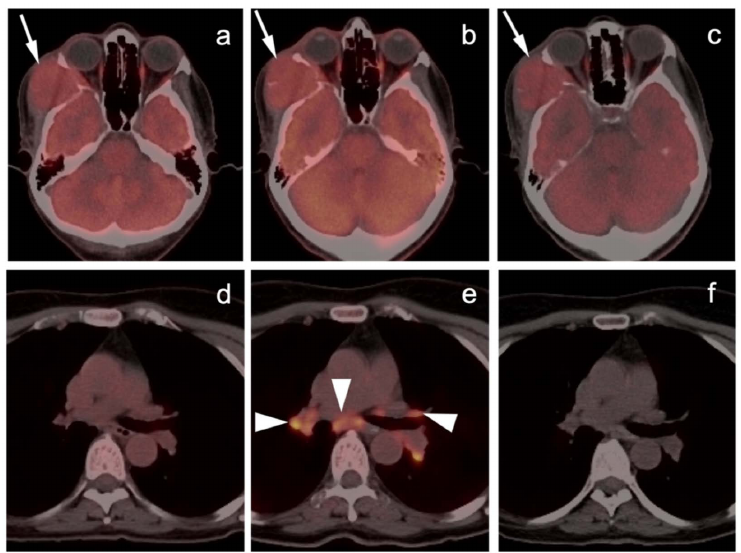
Figure 1. Sarcoidosis-like reaction to immunotherapy. (( a , d ), left panels) Axial FDG PET-CT scan of the head ( a ) demonstrates a hypermetabolic mass (melanoma) invading the right temporalis muscle with lateral intra-orbital extension (white arrow). ( d ) No mediastinal adenopathy is present on axial FDG PET-CT of the upper chest. (( b , e ), middle panels) Follow-up FDG PET scan while on immunotherapy. ( b ) Axial FDG PET-CT scan of the head demonstration that the melanoma in the right temporalis muscle is stable (white arrow). ( e ) Axial FDG PET-CT during immunotherapy demonstrates new hypermetabolic bilateral hilar and subcarinal adenopathy (white arrowheads), that was granulomatous on biopsy; (( c , f ), right panels) Follow-up FDG PET-CT following discontinuation of immunotherapy shows stable melanoma (( c ), white arrow) and resolution of hypermetabolic mediastinal and hilar adenopathy ( f